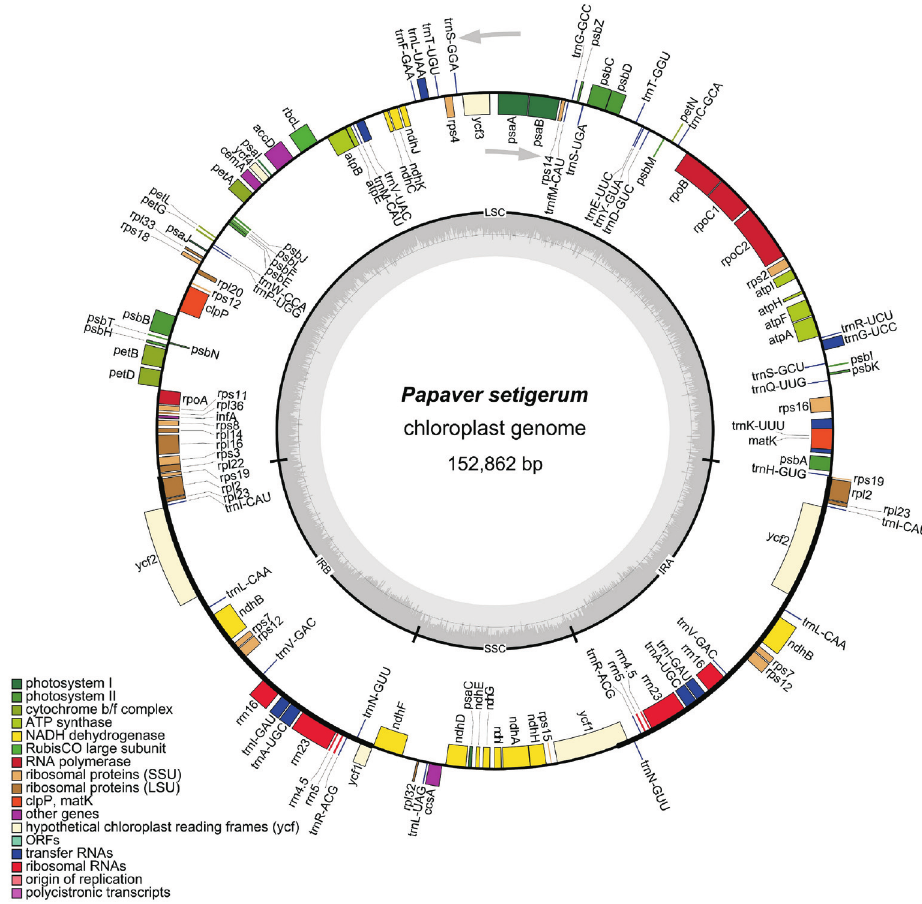
Figure 1 - Chloroplast genome map of Papaver setigerum . Genes inside the circle are transcribed clockwise, genes outside are transcribed coun- ter-clockwise. The light gray inner circle corresponds to the AT content, the dark gray to the GC content. Genes belonging to different functional groups are shown in different